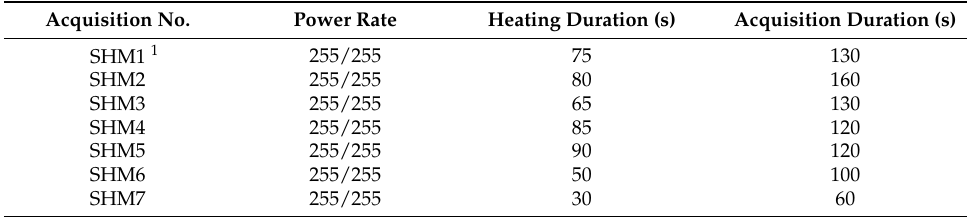
Table 8. Step-heating acquisition protocols applied to the monolithic CFRP sample. Acquisition No.